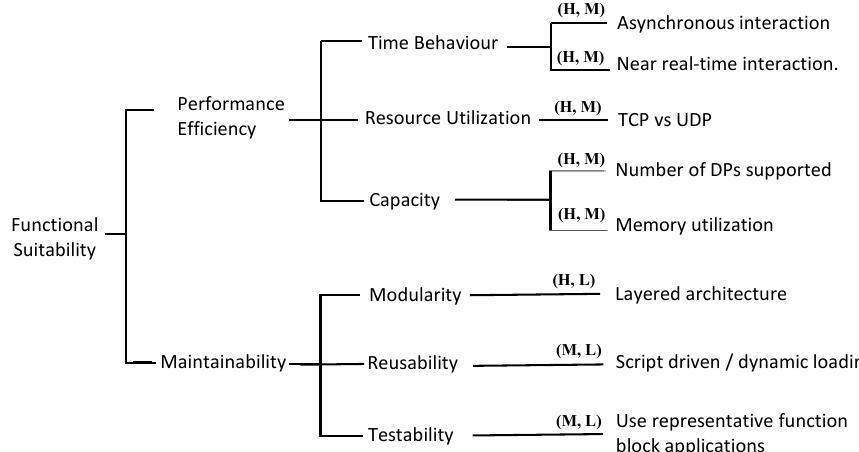
Figure 11. The ATAM utility tree for the